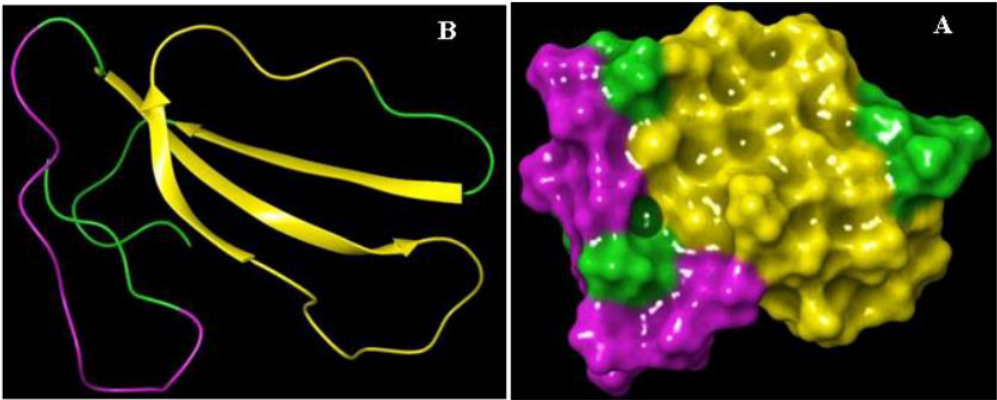
Figure 2. The schematic representation of the 3D structure and epitopes of recombinant cytotoxin-II (rCTII). ( A ) Cartoon and ( B ) surface models. Table 1. B-cell epitope prediction for CTII.